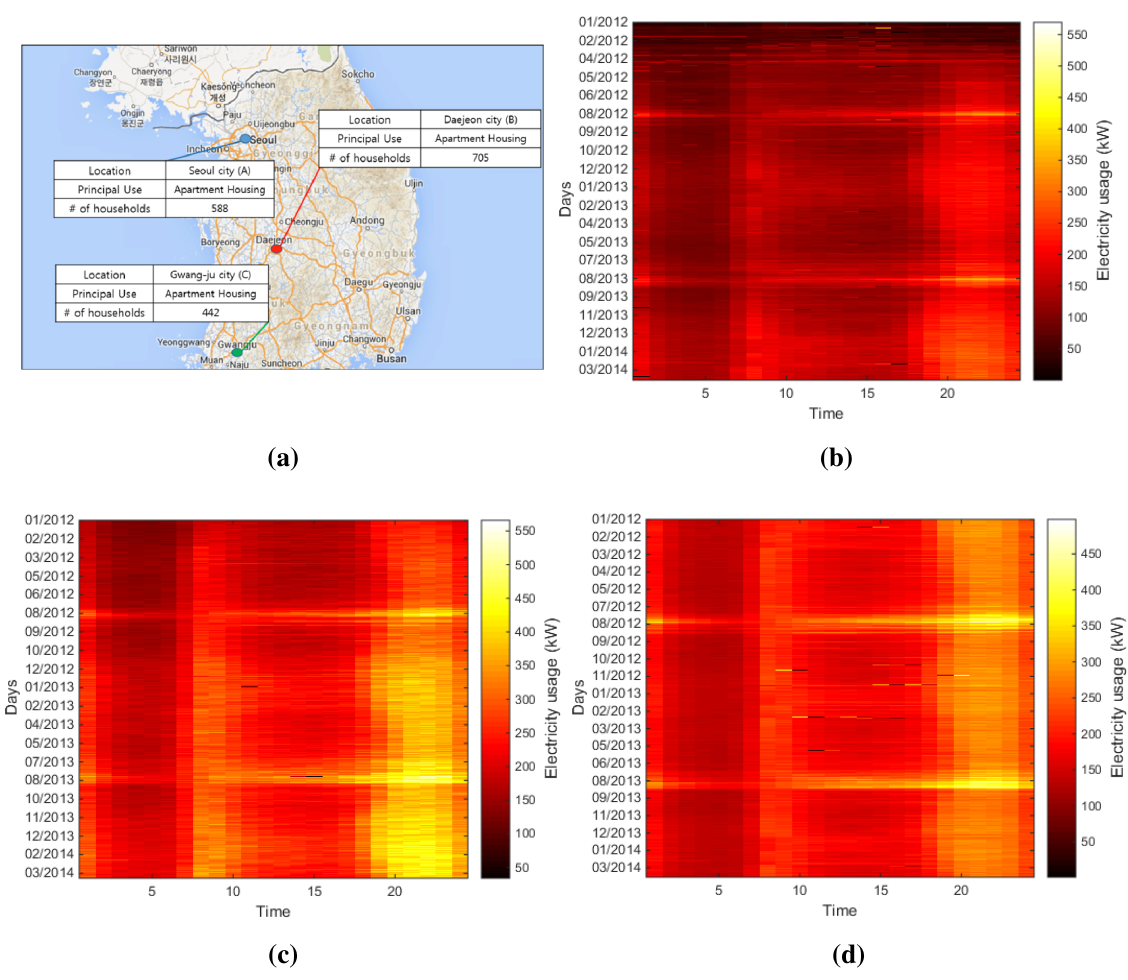
Figure 2. ( a ) Korean residential building information; ( b ) Apartment complex A (Seoul); ( c ) Apartment complex B (Daejeon); ( d ) Apartment complex C (Gwang-ju). Bright color indicates high energy